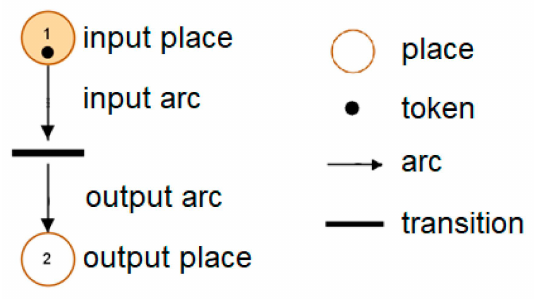
Figure 1. Basic elements of Petri